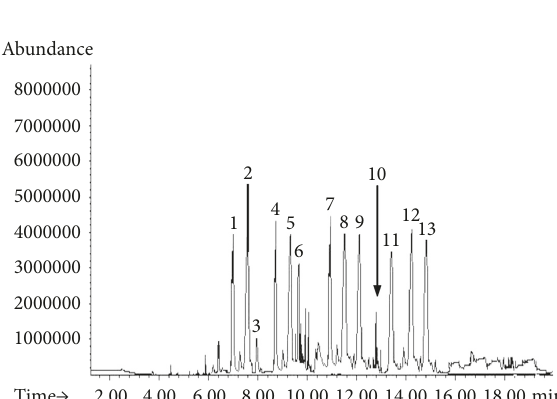
Figure 4: The UHPLC chromatogram for Beta vulgaris L peels and pomace Figure 5. The protonated 2- O -glucosyl-betanin, 2- O -glu- cosyl-isobetanin, and isobetanin (isobetanidin 5-glucoside) molecules (peaks 1, 3, and 4) resulted probably in loss of glucose to achieve m / z of 345.1, 389.1, and 345.1, respec-